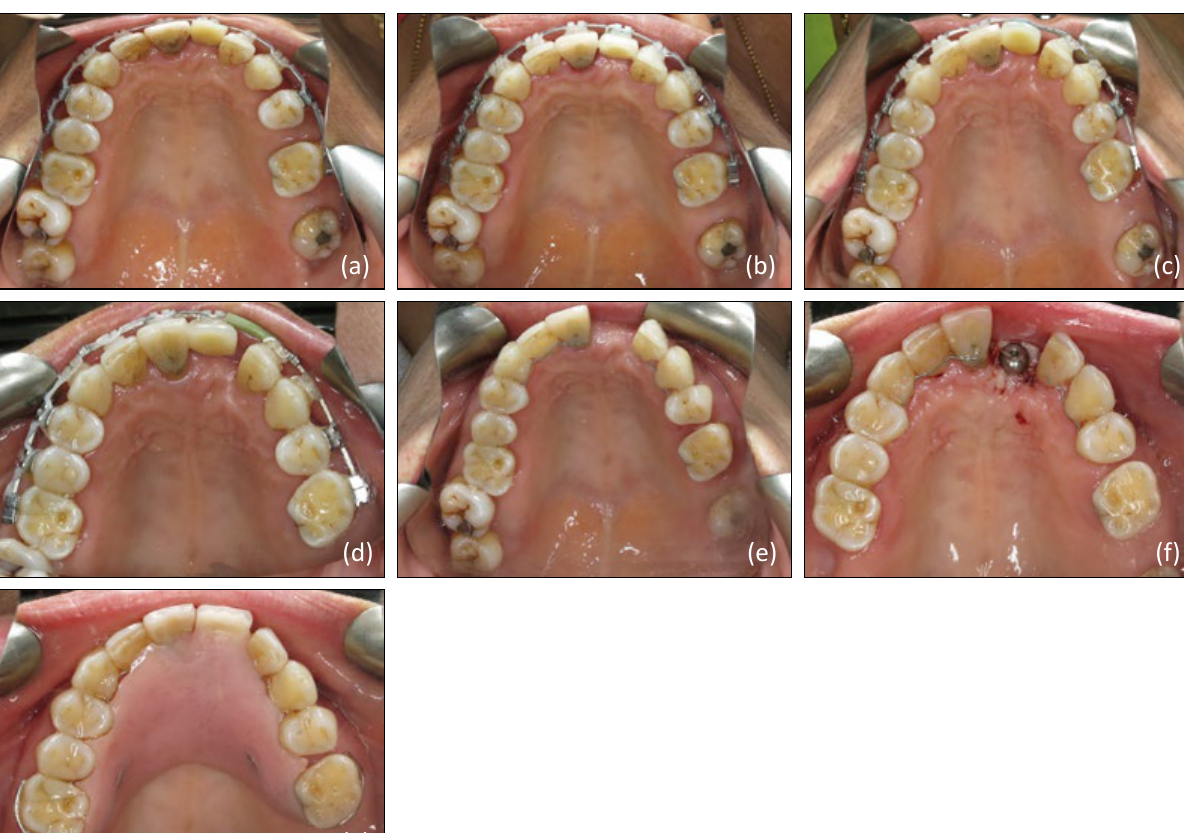
Figure 11. Upper occlusal photographs of treatment progress at various time-points: (a) three months, (b) five months, (c) eight months, (d) 14 months, (e) 19 months, (f) 23 months – following stage 2 implant surgery, (g) 23 months – with immediate removable acrylic partial denture in place.